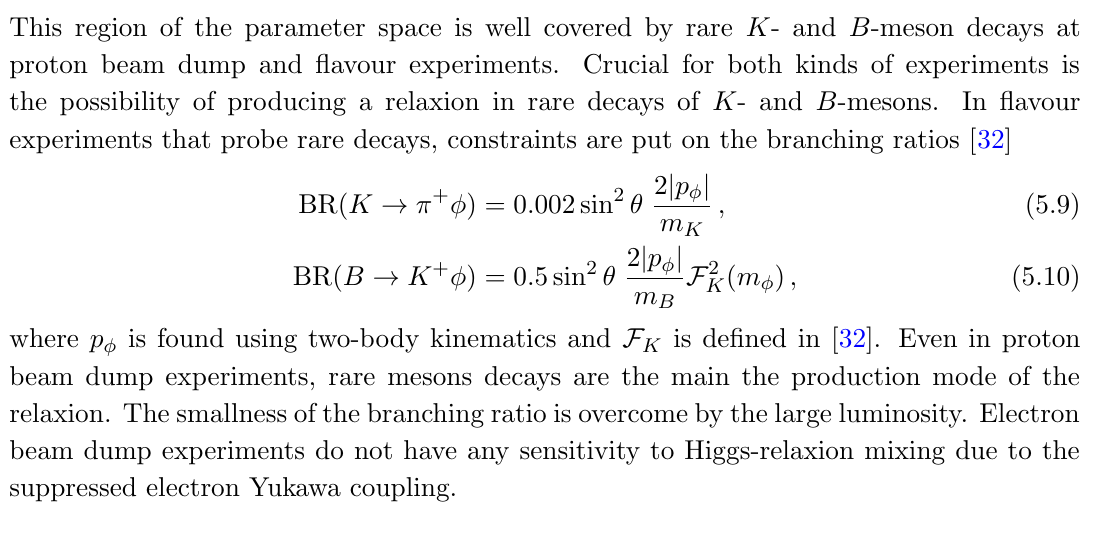
’ 104 GeV (gray, thick, br